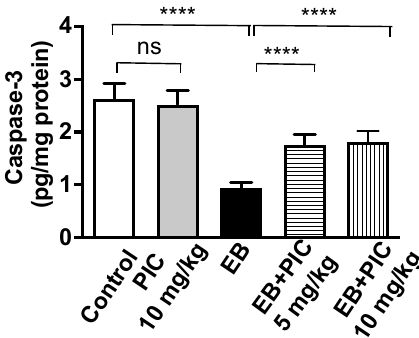
Figure 4. Effect of PIC SNEDDS treatment on caspase-3 concentration in the uterine tissue. Data are shown as Mean ± S.D ( n = 6). ns = not significant and **** p < 0.0001 by one-way ANOVA with Tukey’s post hoc test.